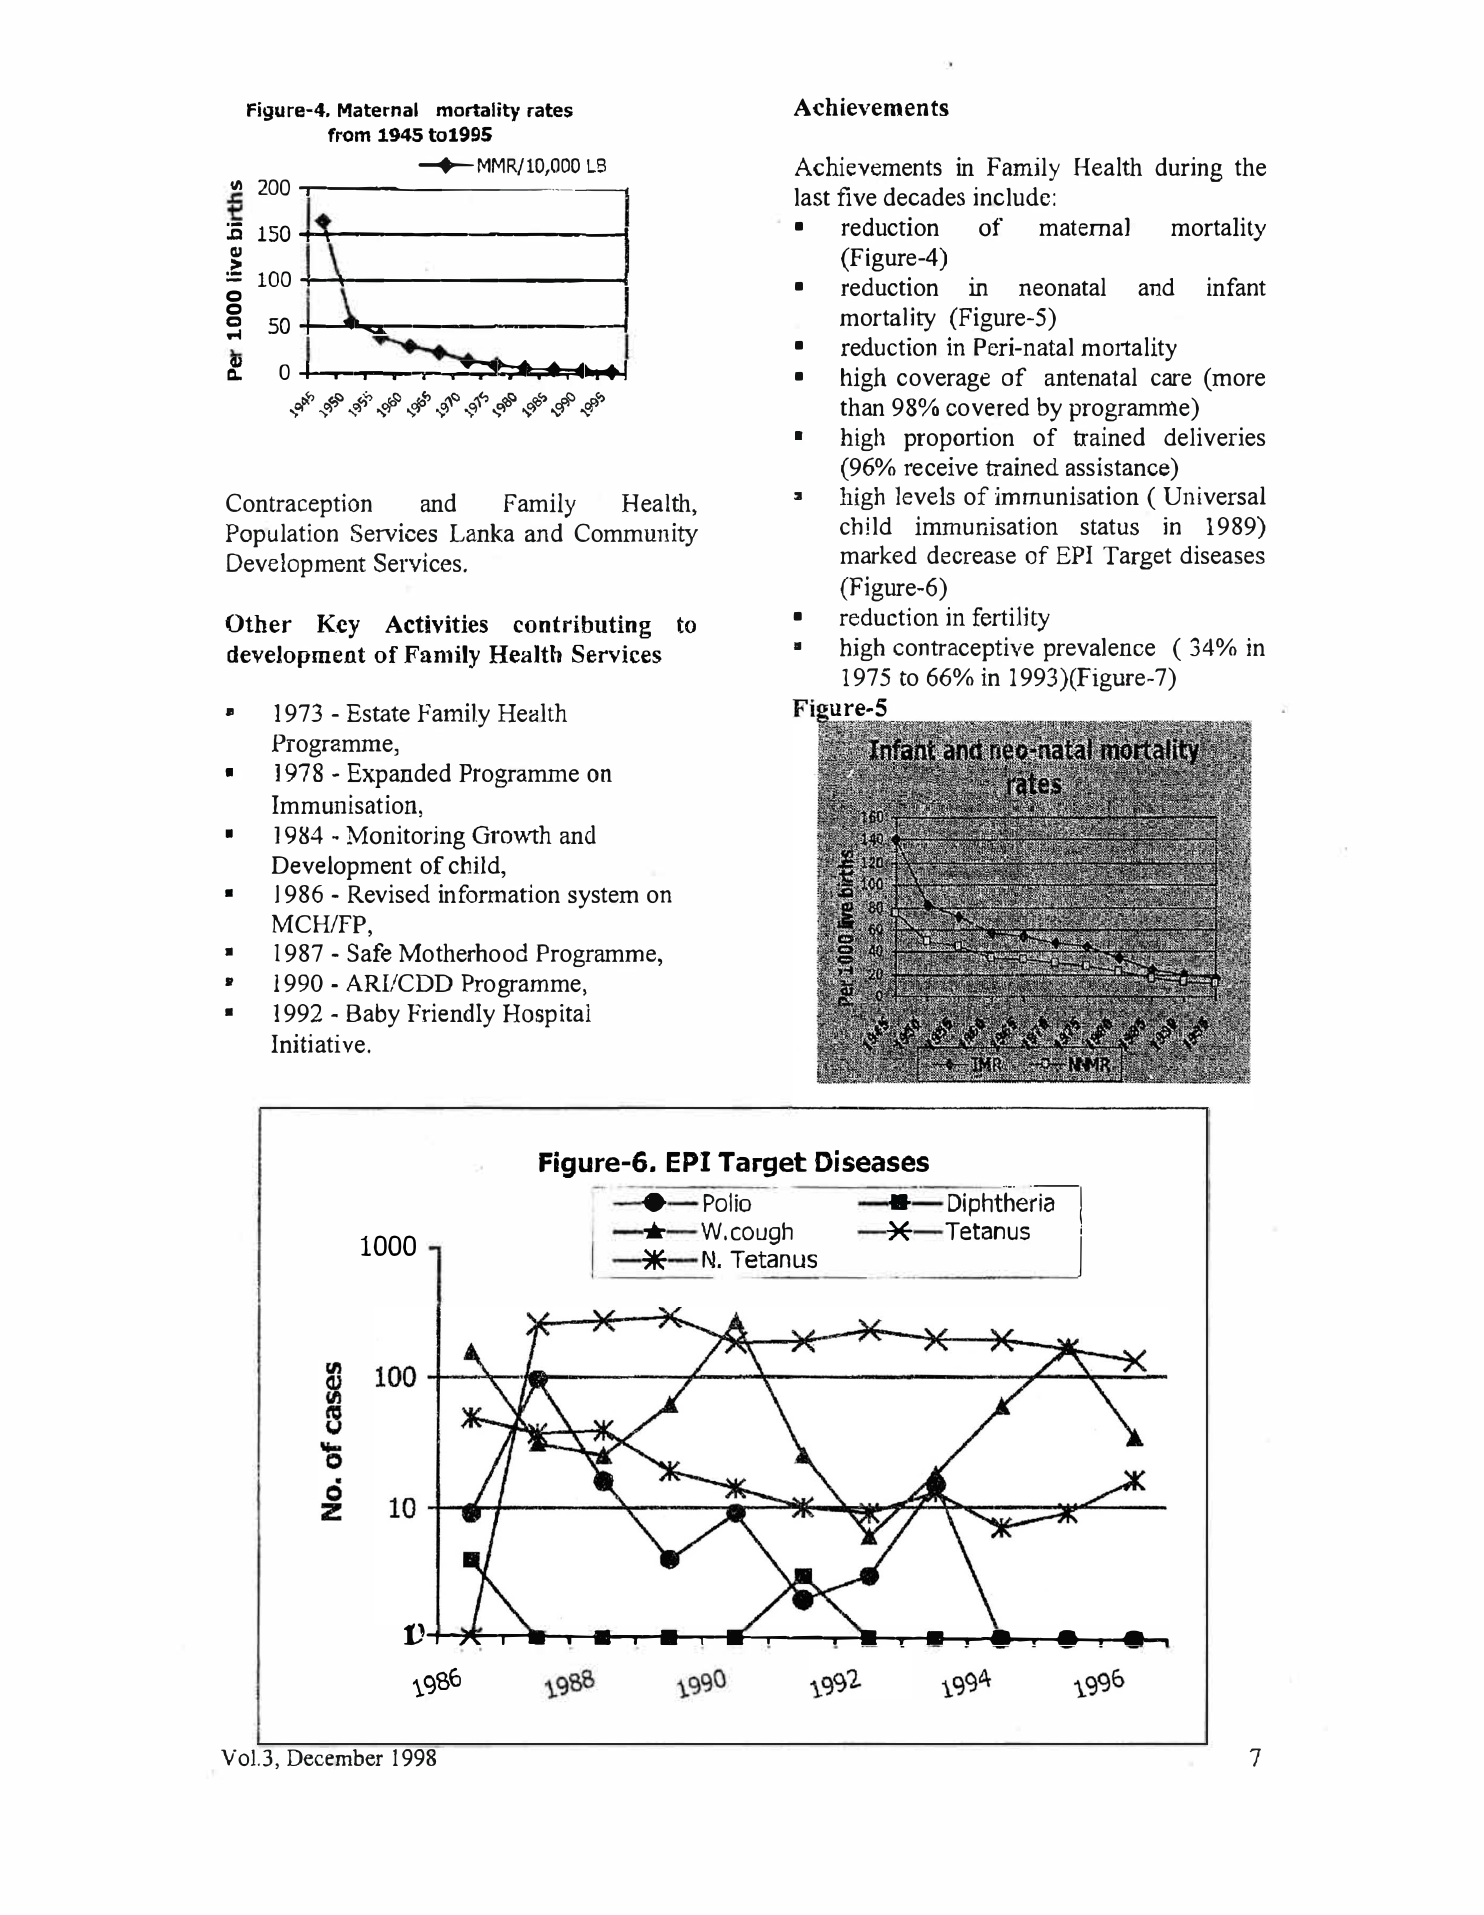
Figure-4. Maternal mortality rates from 194S to1995 -+-MMR/10,000 LB